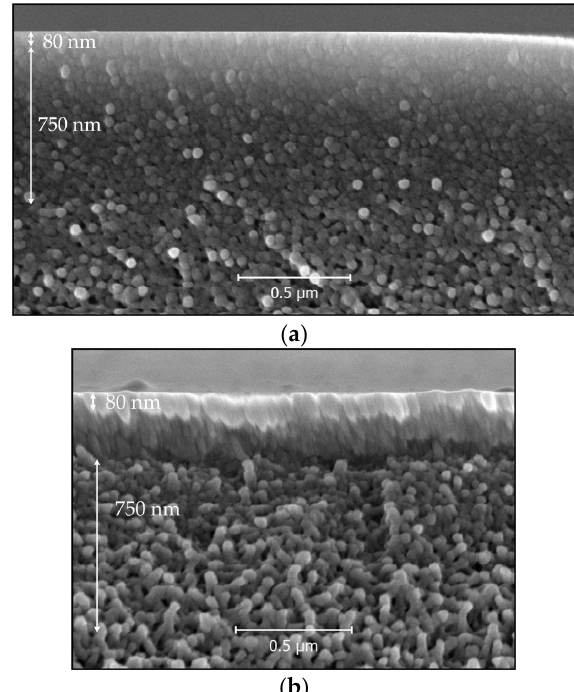
Figure 4. ( a ) SEM micrographs of hollow fiber cross-section with a close-up of the selective layer; ( b ) the selective layer is slightly peeled off.